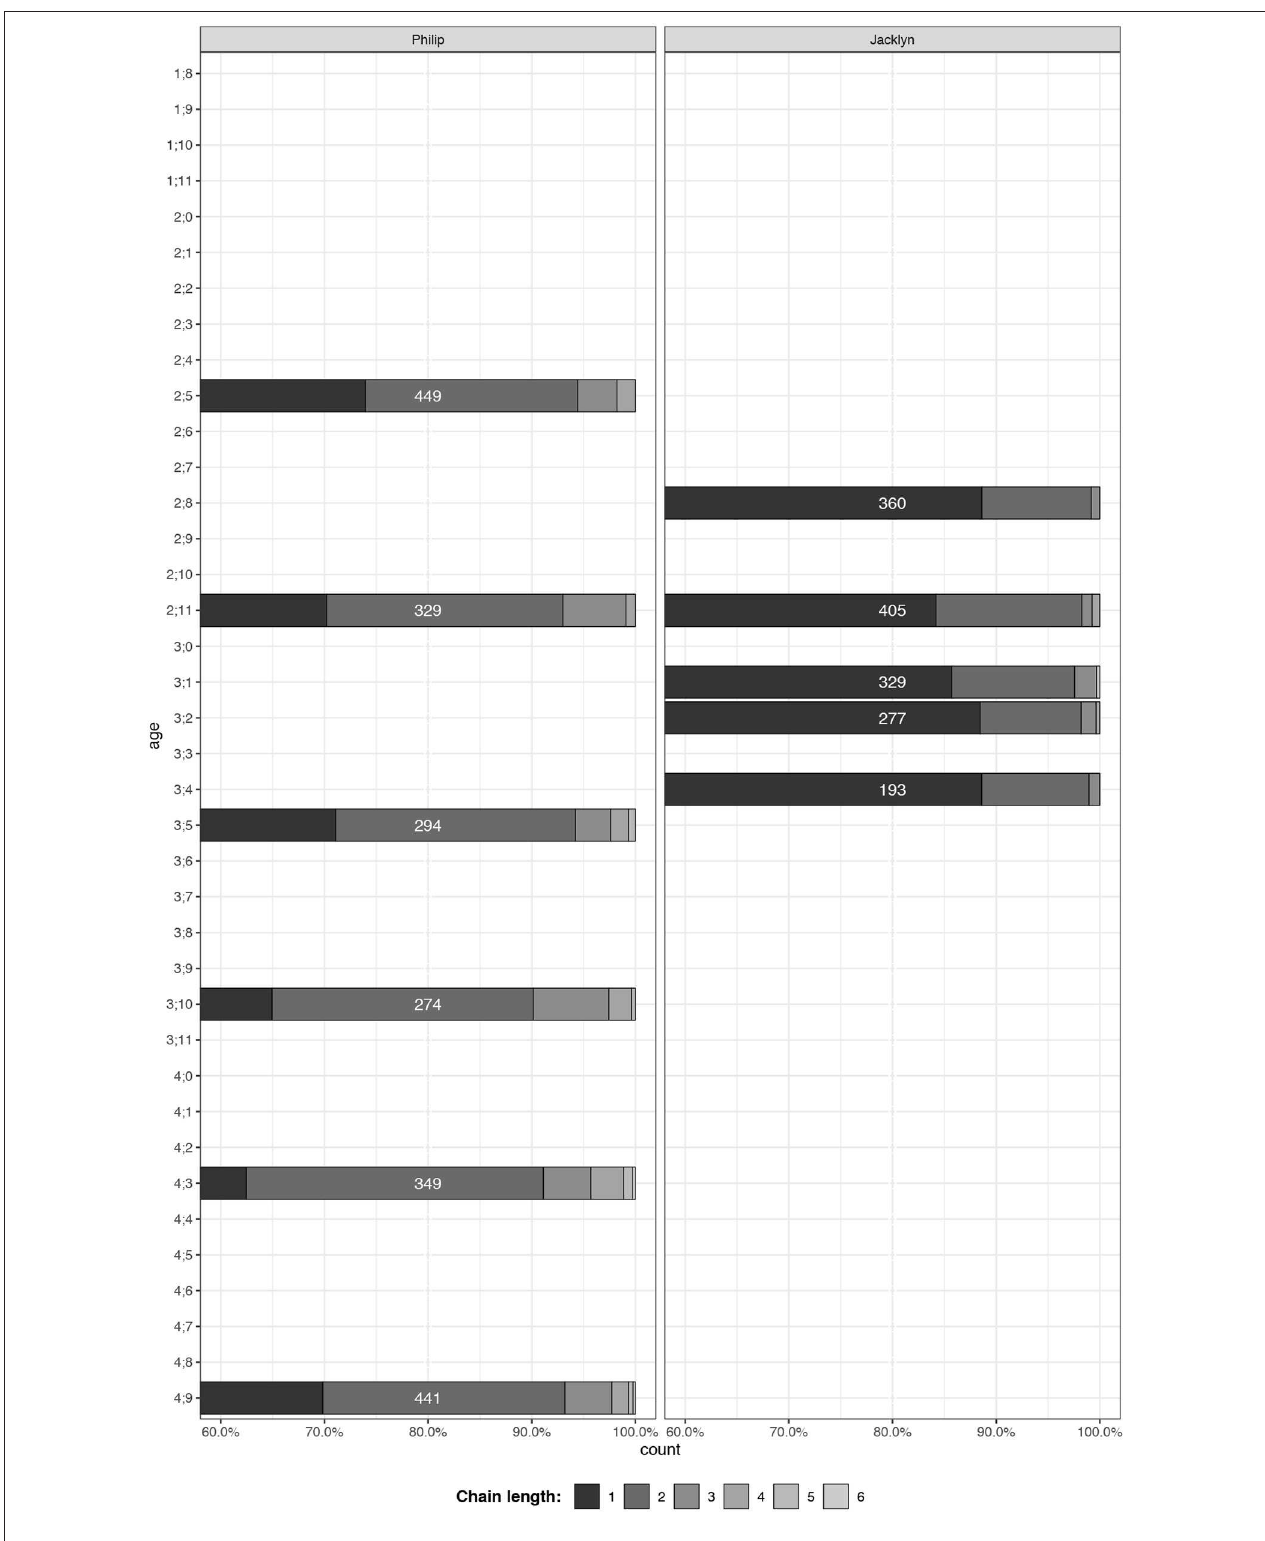
FIGURE 8 | Lengths of clause chains in speech of adults to Philip and Jacklyn.